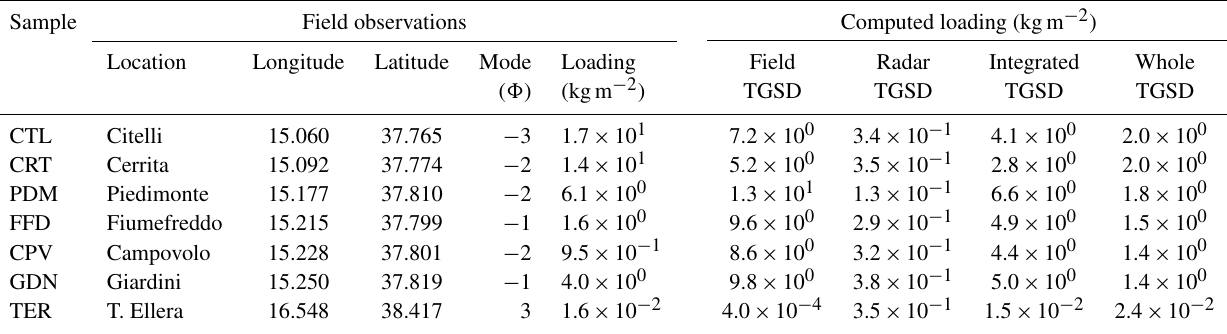
Table 1. Field measurements (locations, loadings, and modes) with the computed tephra loadings obtained with the ARPAE database for the explored TGSDs (Fig.